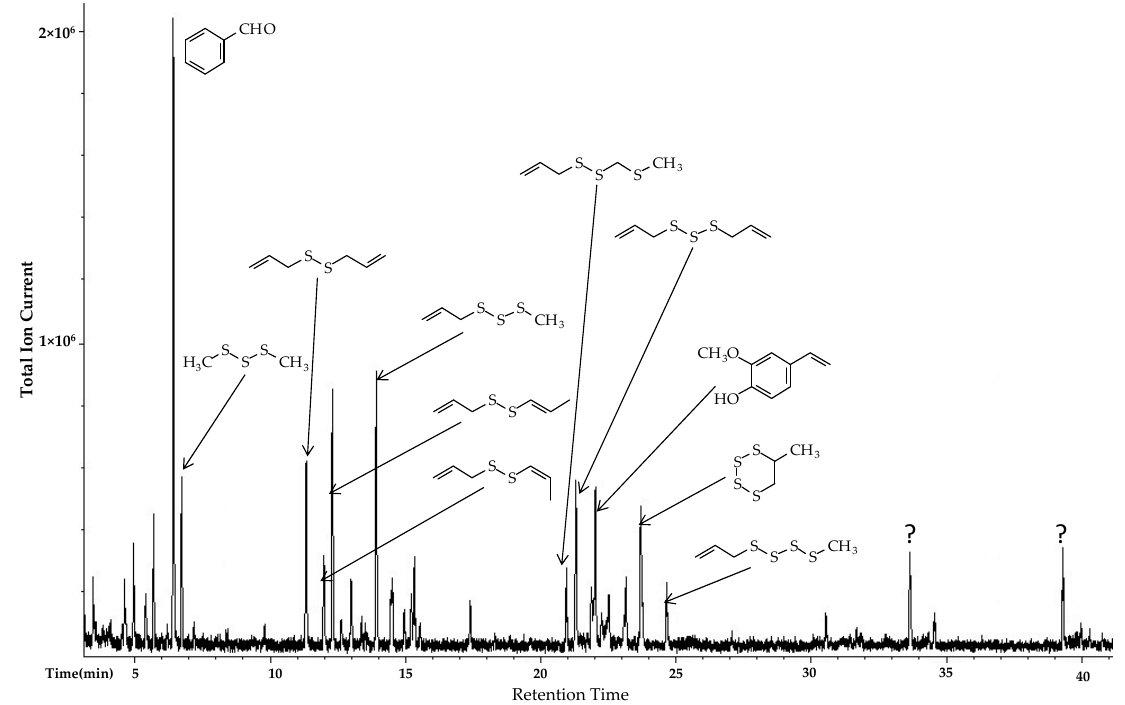
Figure 3. Chromatogram of Allium vineale essential oil sample #4 showing major components. ? = unidentified